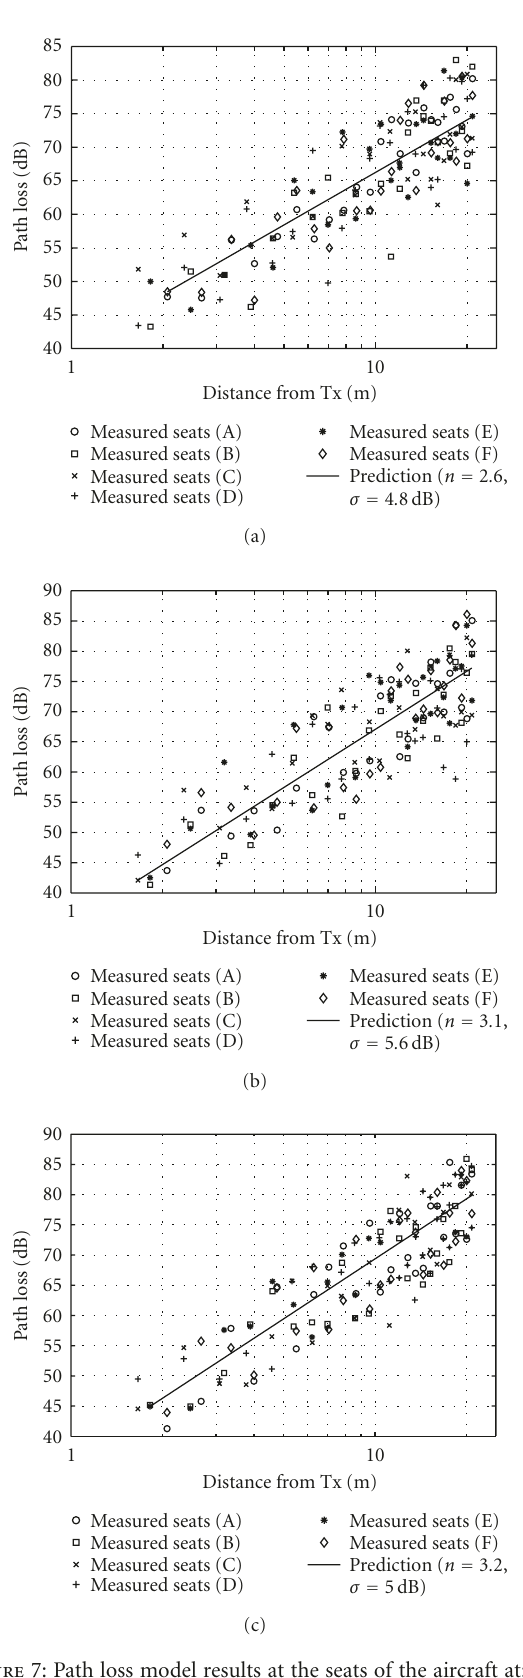
Figure 7: Path loss model results at the seats of the aircraft at: (a) 1.8GHz, (b) 2.1GHz, and (c) 2.45